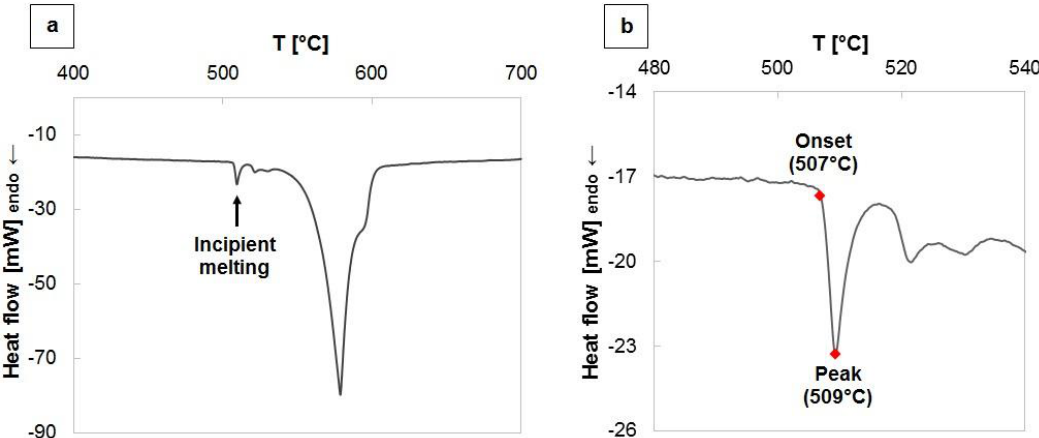
Figure 3. Differential thermal analyses (DTA) carried out on the as-cast A354 alloy, ( a ) highlighting the presence of a low melting compound at 509 °C. ( b ) The incipient melting reaction readapted from Reference [21].